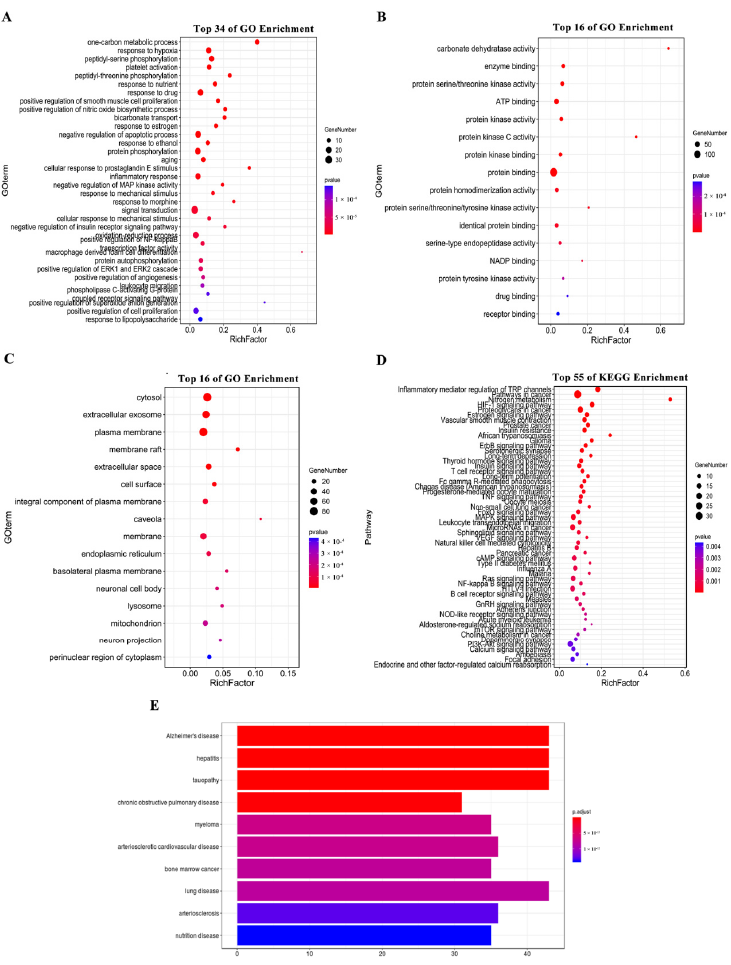
Figure 2. ( A – C ) GO enrichment analysis of 199 potential targets in terms of biological processes, cellular components, and molecular functions. ( D ) Enrichment analysis of KEGG pathways and ( E ) disease enrichment analysis of 199 potential